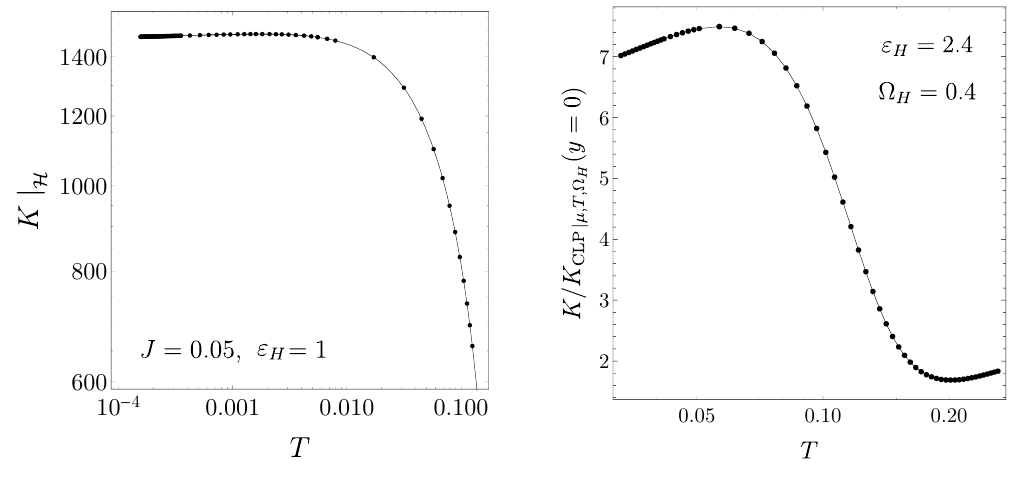
Figure 10 . Left : the log-log plot of the Kretschmann curvature scalar K = R abcd R abcd against the temperature, for (cid:12)xed angular momentum J = 0 : 05 and horizon scalar (cid:12)eld " H = 1. Right : Kretschmann curvature invariant at the horizon y = 0 for the hairy black hole with constant horizon values " H and (cid:10) H , scaled by the K value of a corresponding CLP black hole in the grand-canonical ensemble, i.e. with the same (cid:22) , T and (cid:10) H . The ratio remains (cid:12)nite as we approach the BPS bound, and the black hole family shrinks to a smooth solitonic